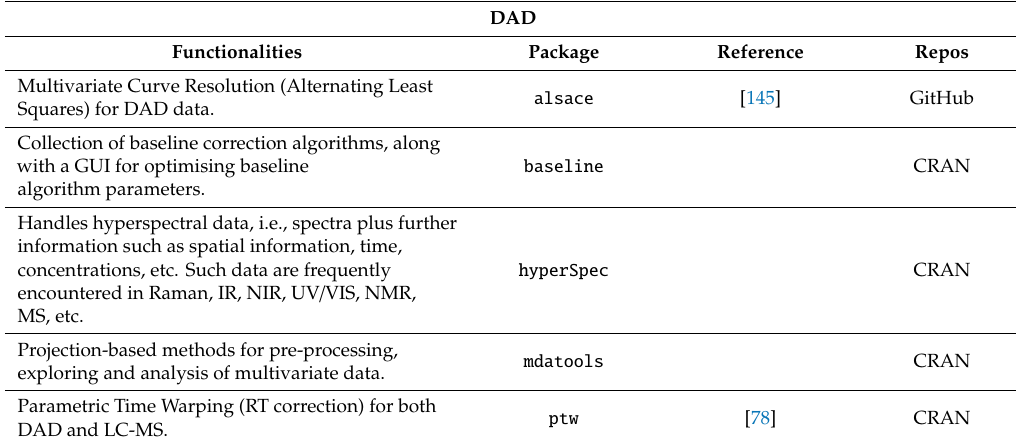
Table 5. R packages for UV data handling and